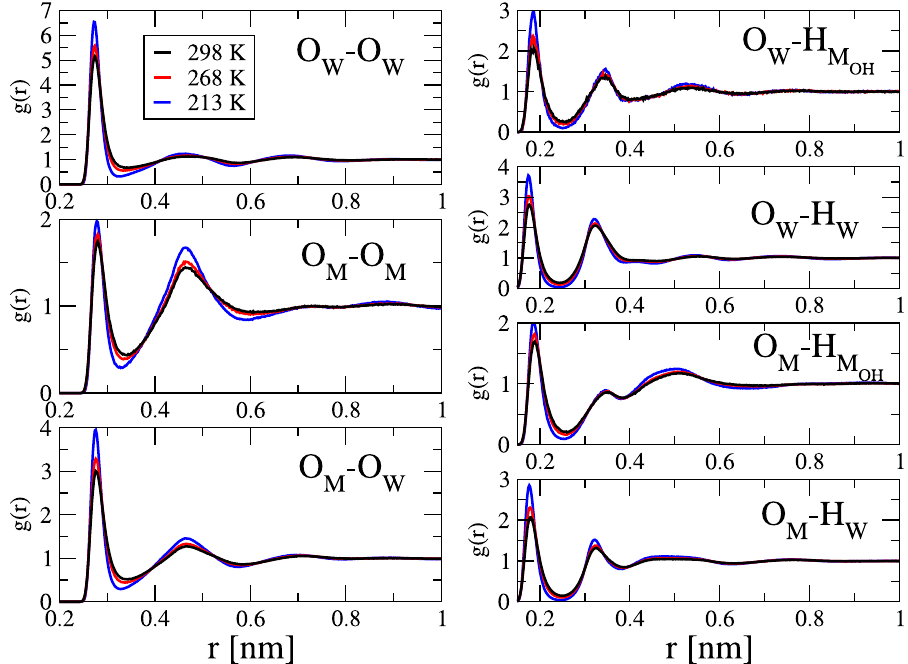
Figure 2. Temperature dependence of computer simulated partial radial distribution functions of water- methanol mixture with a methanol molar ratio of 0.4. Only the PRDF-s that are related to hydrogen bonding are shown. Changes with temperature are systematic (although hardly